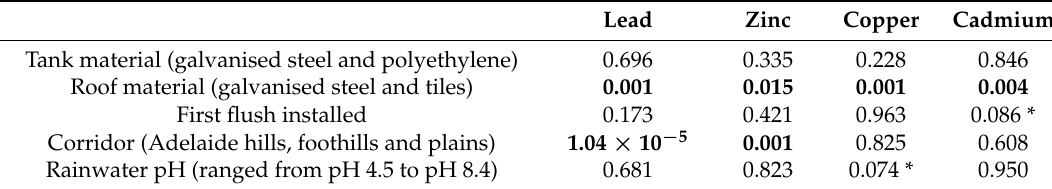
Table 2. Relationships between metal concentrations and various parameters.